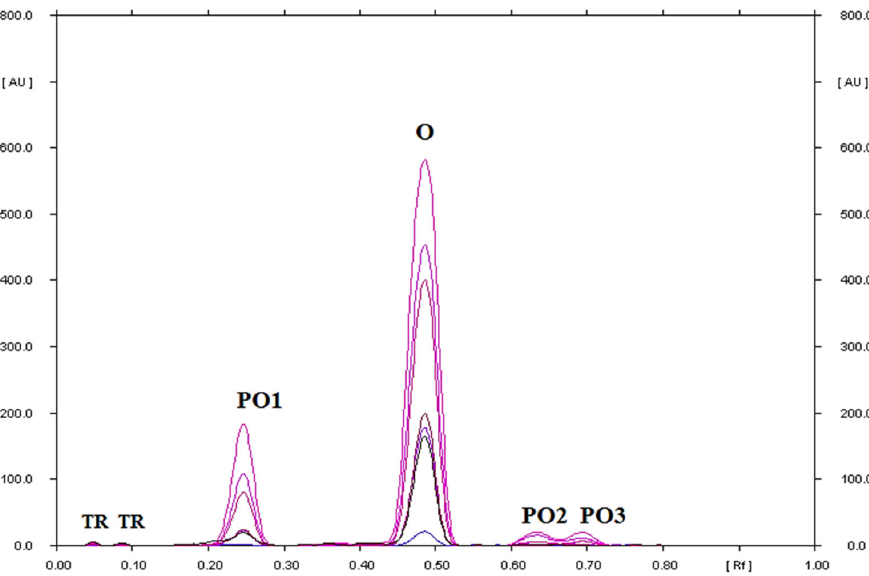
Figure 11. TLC-UV densitograms recorded in the multi wavelength from 200 to 380 nm (at wavelength intervals of 30 nm at each step) of ornidazole in water at pH = 5.56 solution, which after heating at 40 ◦ C for 1000 h was separated on silica gel using a mobile phase chloroform–methanol (9:1, v / v ), where O is ornidazole, PO1, PO2, and PO3 are the degradation products of ornidazole, and TR is the traces.